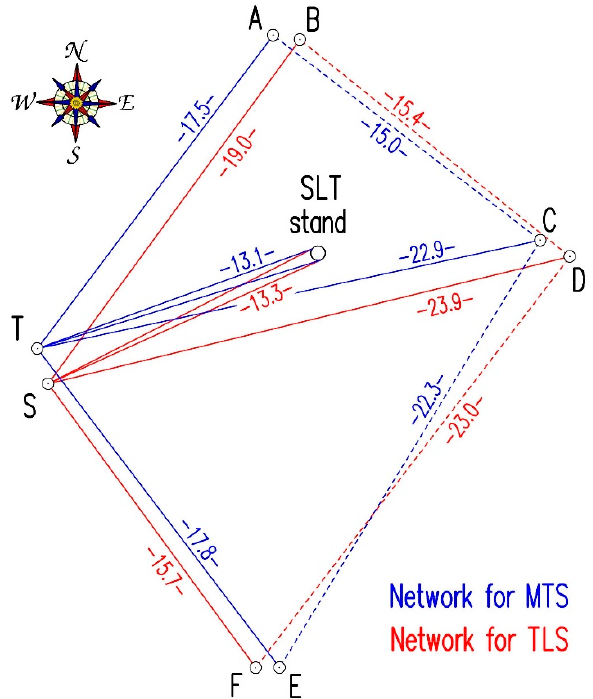
Figure 6. The layout of the instrument positions and measured points.